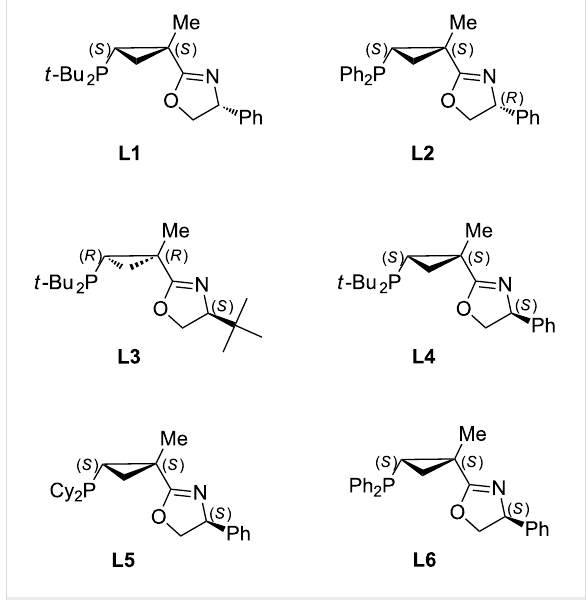
Figure 3: PHOX ligands with chiral cyclopropyl backbone employed in this